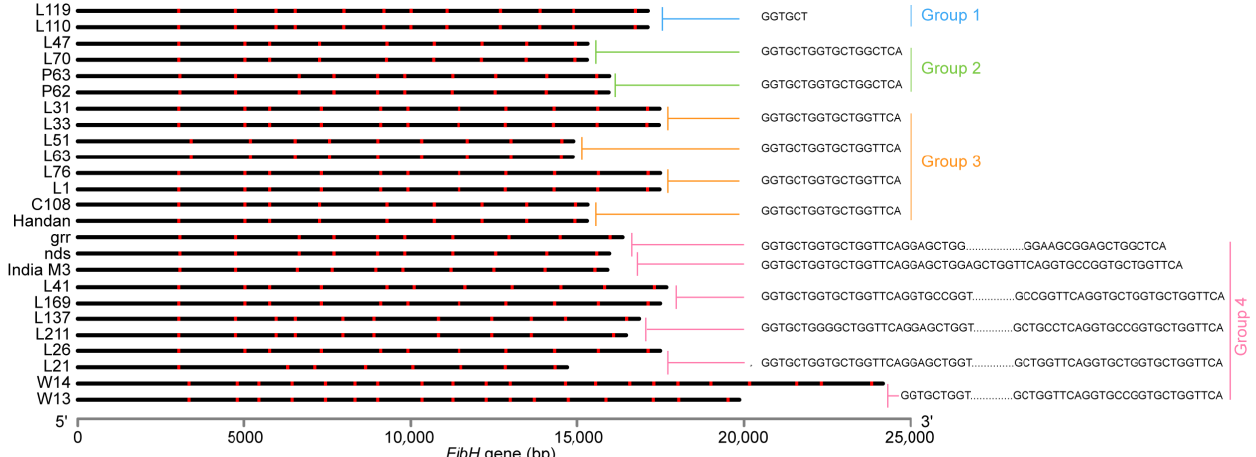
Figure 4. FibH gene with differential sequence. The nucleotide sequence is the differential sequence between two adjacent silkworm FibH genes. All differential sequences were divided into four groups. The FibH gene and the amorphous region identified by Nde I are represented by black horizontal lines and red blocks, respectively.